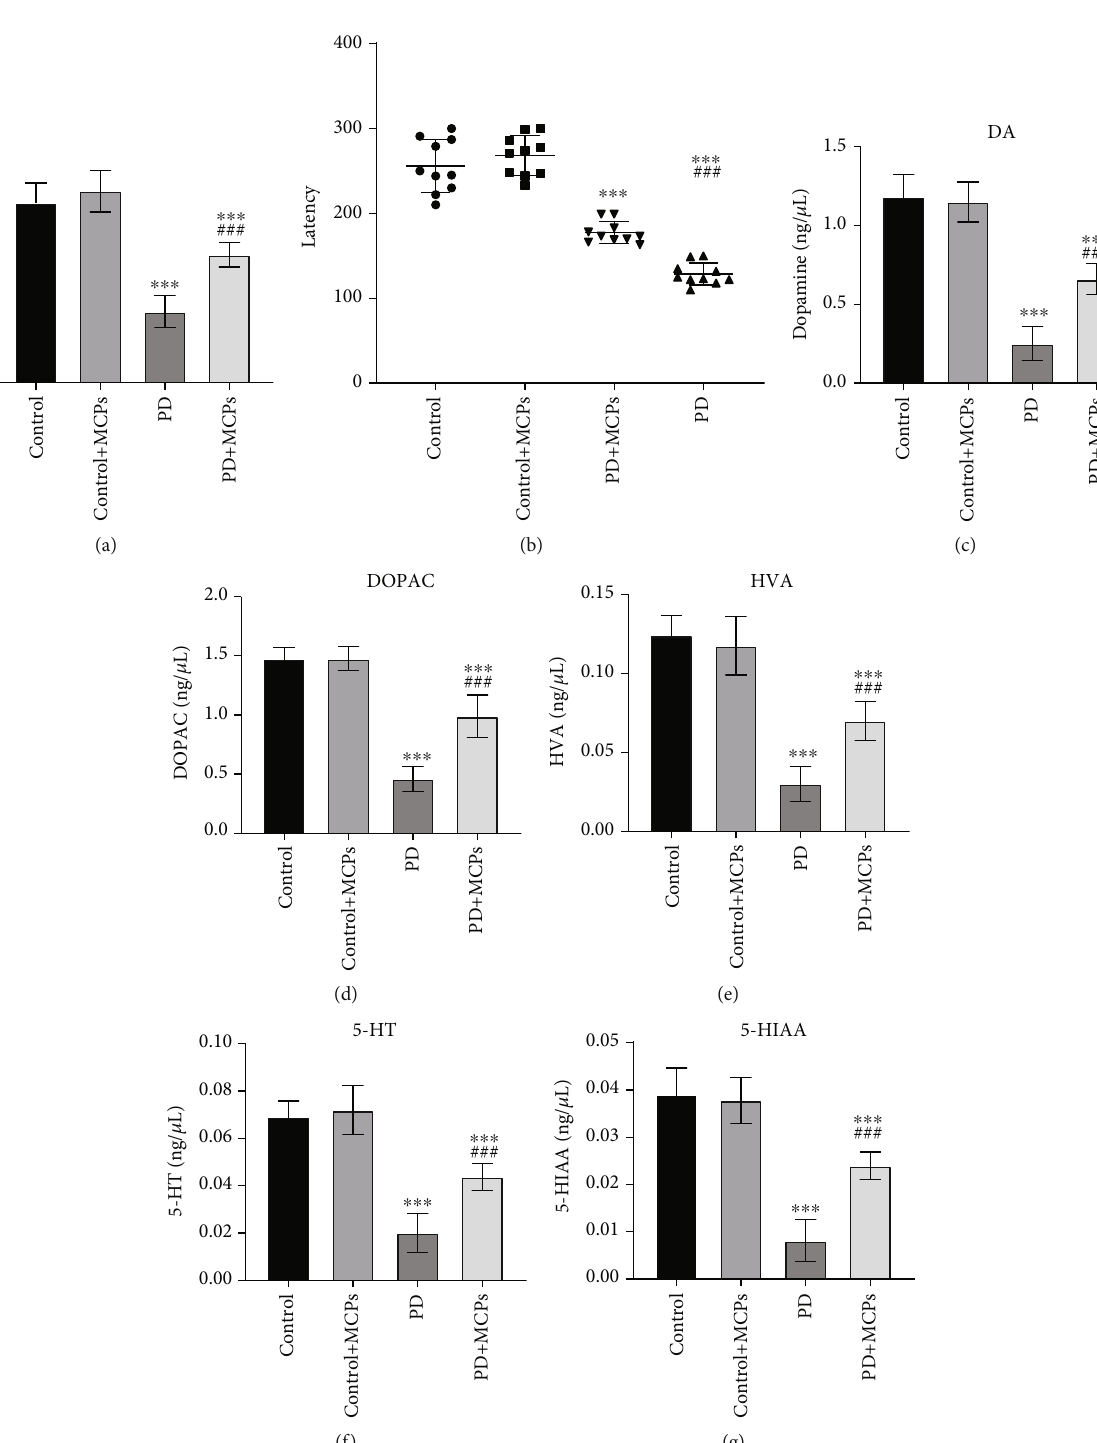
Figure 2: MCPs reduce the dyskinesia of MPTP-induced PD and regulate DA and 5-HT metabolism. (a) Pole climbing test score. (b) Rotarod test retention ability. (c – g) DA, DOPAC, HVA, 5-HT, and 5-HIAA levels in striatum tissue homogenate. Compared with the Control group (Control+MCPs group), ∗∗∗ P < 0 : 001 , and compared with the PD group, ### P < 0 : 001